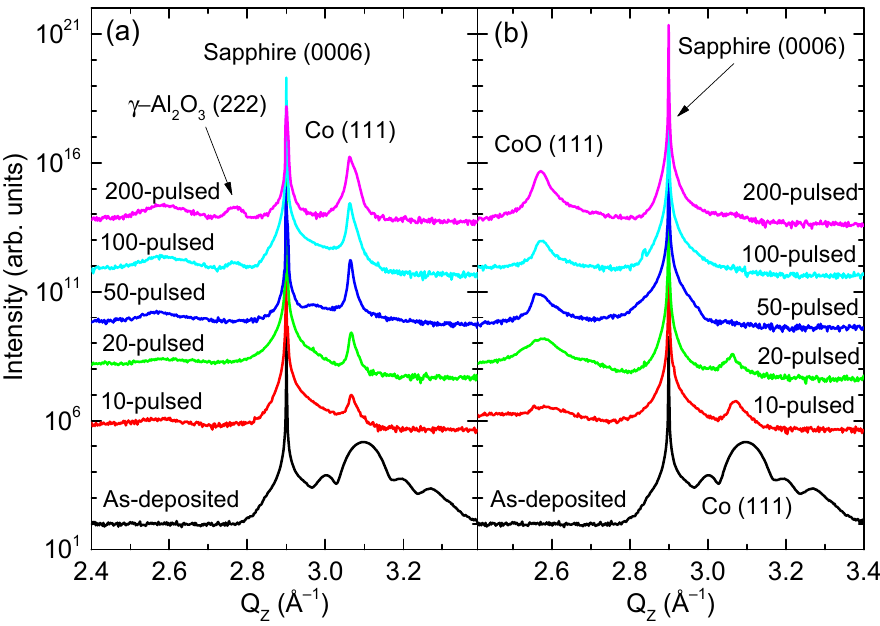
Figure 1. Series of XRD profiles of the samples irradiated in vacuum ( a ) and air ( b ). Observation of the γ -Al 2 O 3 (222) peak is associated with the formation of the γ -Al 2 O 3 wetting ridge.